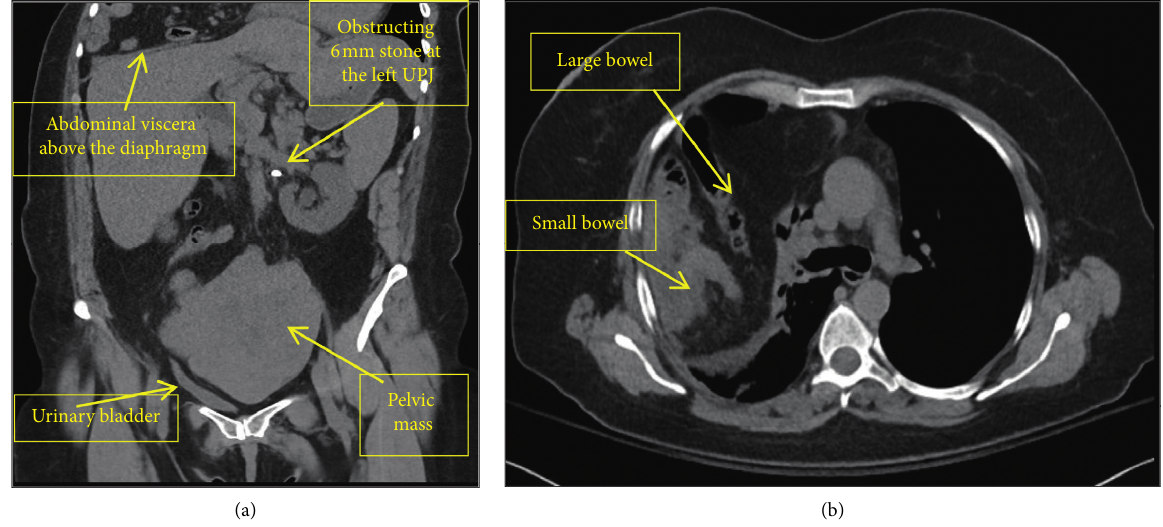
Figure 1: Axial (a) and coronal (b) views of CT (computed tomography) thorax, abdomen, and pelvis which revealed 6 mm left obstructing ureterolithiasis with hydronephrosis, as well as incidentally noted large 13cm heterogeneous mass within the pelvis resulting in distortion of local structures. Additionally visualized was a large Morgagni hernia containing a large majority of the small bowel, the transverse colon, a portion of the descending colon, and a portion of the stomach with significant adjacent atelectasis of right lower lung